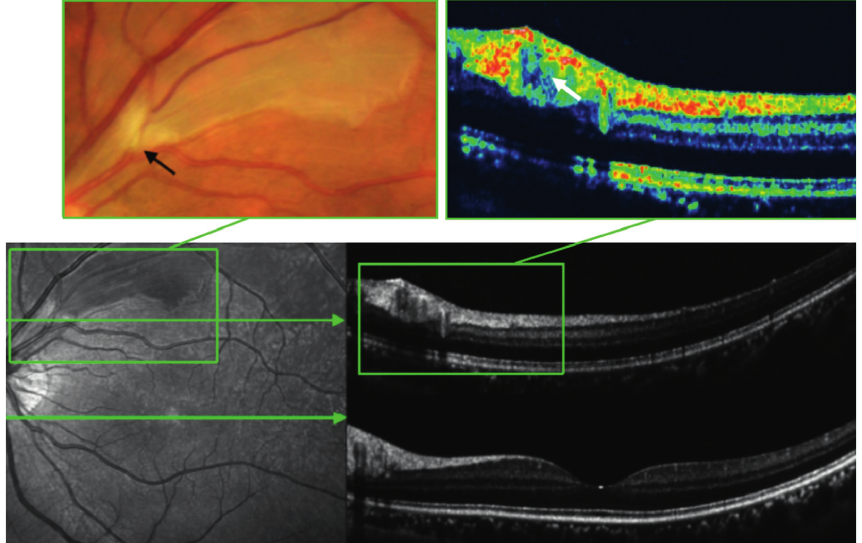
Figure 2: Optical coherence tomography revealed increased thickness of the inner retinal layers and normal fovea. Blown-up fundus photograph revealed a plaque within the supertemporal artery (black arrow). Blown-up optical coherence tomography (pseudo-color) revealed blocked artery with highly reflective material (white arrow) in the corresponding